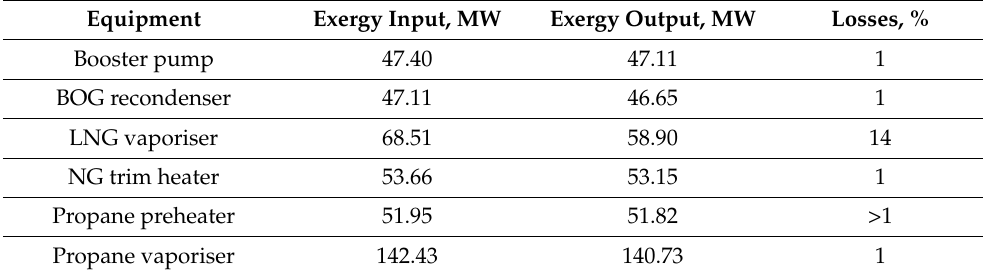
Table 4. Exergy balance of the regasification process in Case